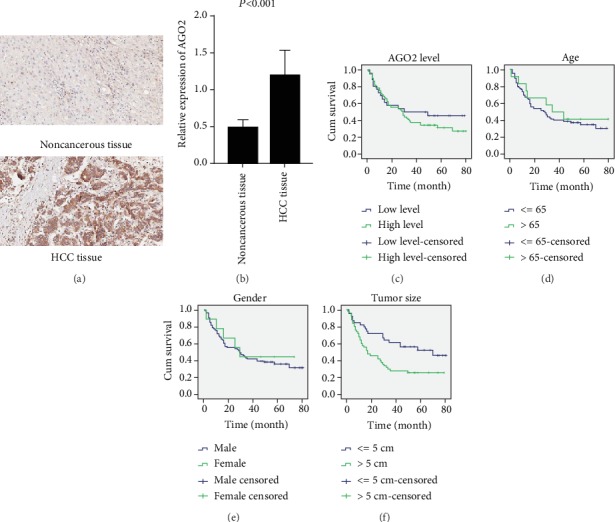
Clinical analysis of AGO2 expression in hepatocellular carcinoma patients. (a) Representative image of AGO2 IHC staining in noncancerous (epithelium) tissues and HCC tissues. (b) Relative expression levels of AGO2 in noncancerous and HCC tissues were determined by measuring the staining intensity (ratings: 0, 1, 2, and 3). Values represented as the means ± S.D. (n = 87). Kaplan-Meier survival analysis according to AGO2 expression (c), age (d), gender (e), and tumor size (f) in 90 patients with HCC (log-rank test). Probability of survival of patients: (c) low expression of AGO2 (n = 26) vs. overexpression of AGO2 (n = 61) (P = 0.037); (d) age > 65 (n = 12) vs. age≦65 (n = 77) (P = 0.597); (e) male (n = 81) vs. female (n = 9) (P = 0.625); (f) tumor size > 5 cm (n = 50) vs. tumor size≦5 cm (n = 39) (P = 0.005).